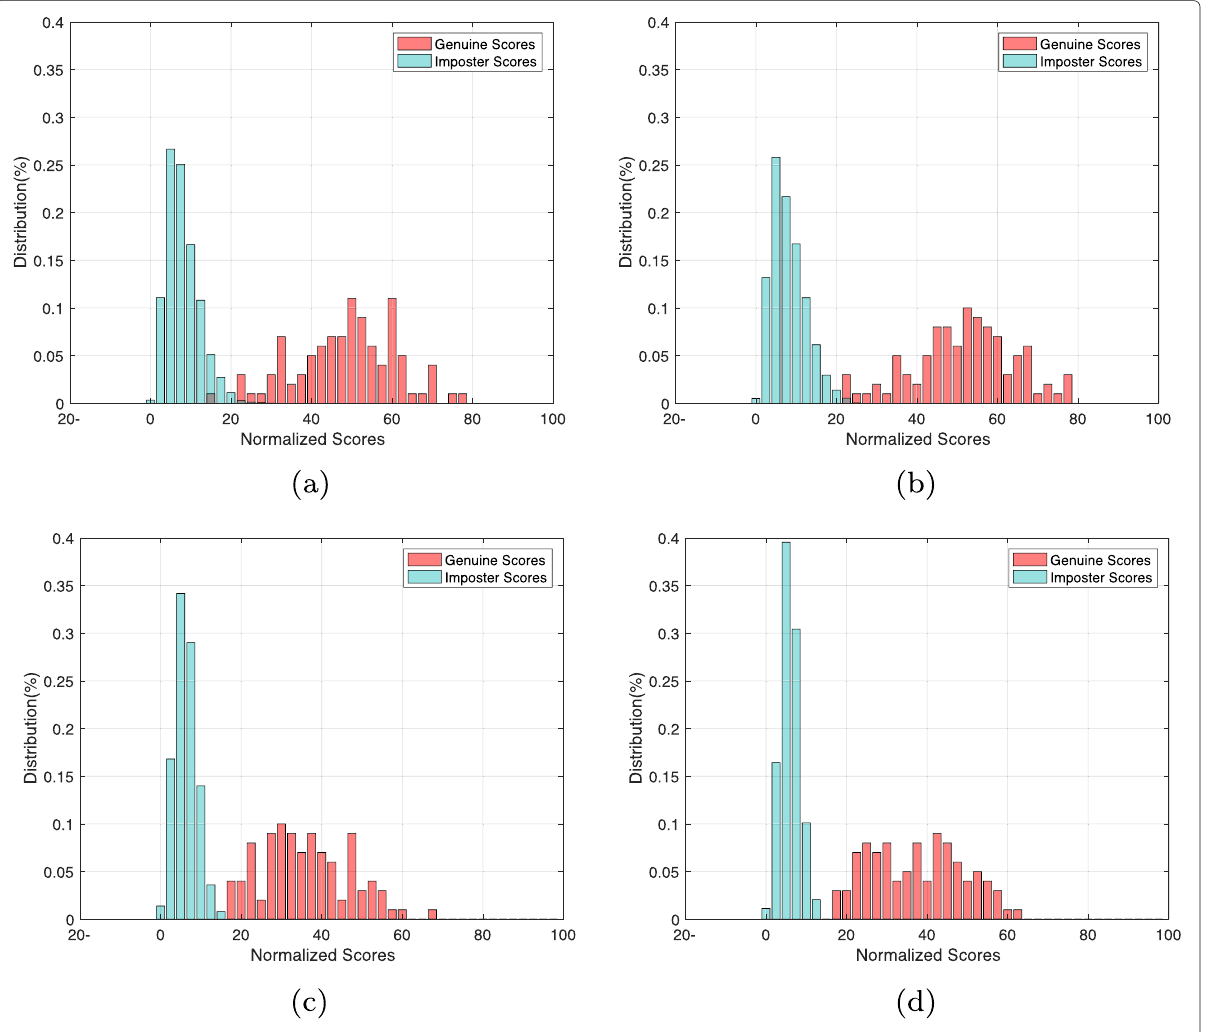
Fig. 4 The genuine-imposter scores distribution for the unprotected system on FVC 2002 DB1 ( a ) and DB2 ( b ), and for the proposed system under Different-key scenario on FVC 2002 DB1 ( c ) and DB2 ( d